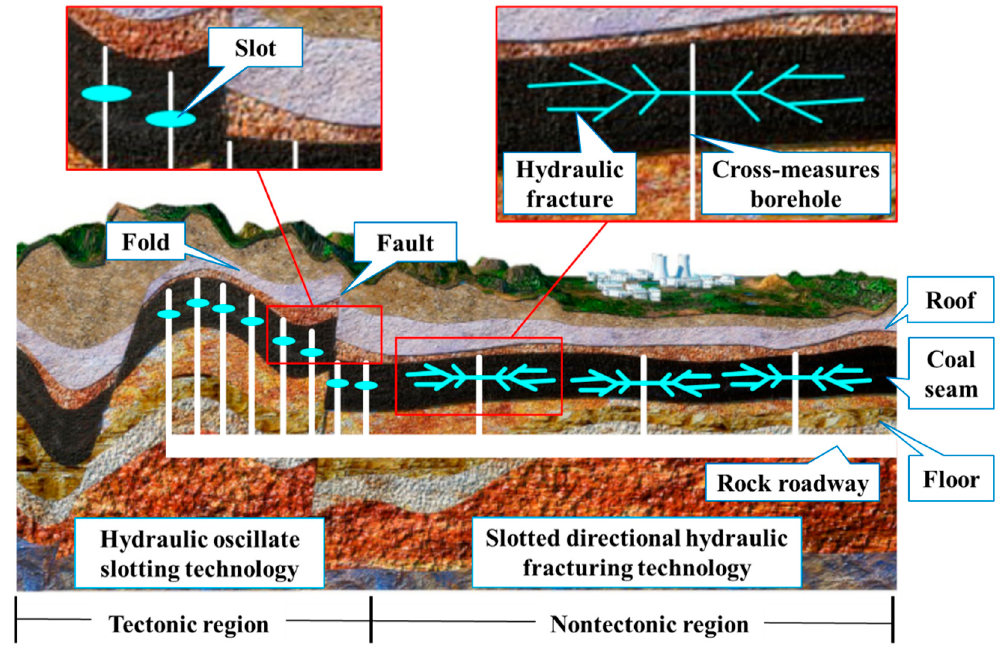
Figure 1. Schematic diagram of the novel hydraulic technology mode.